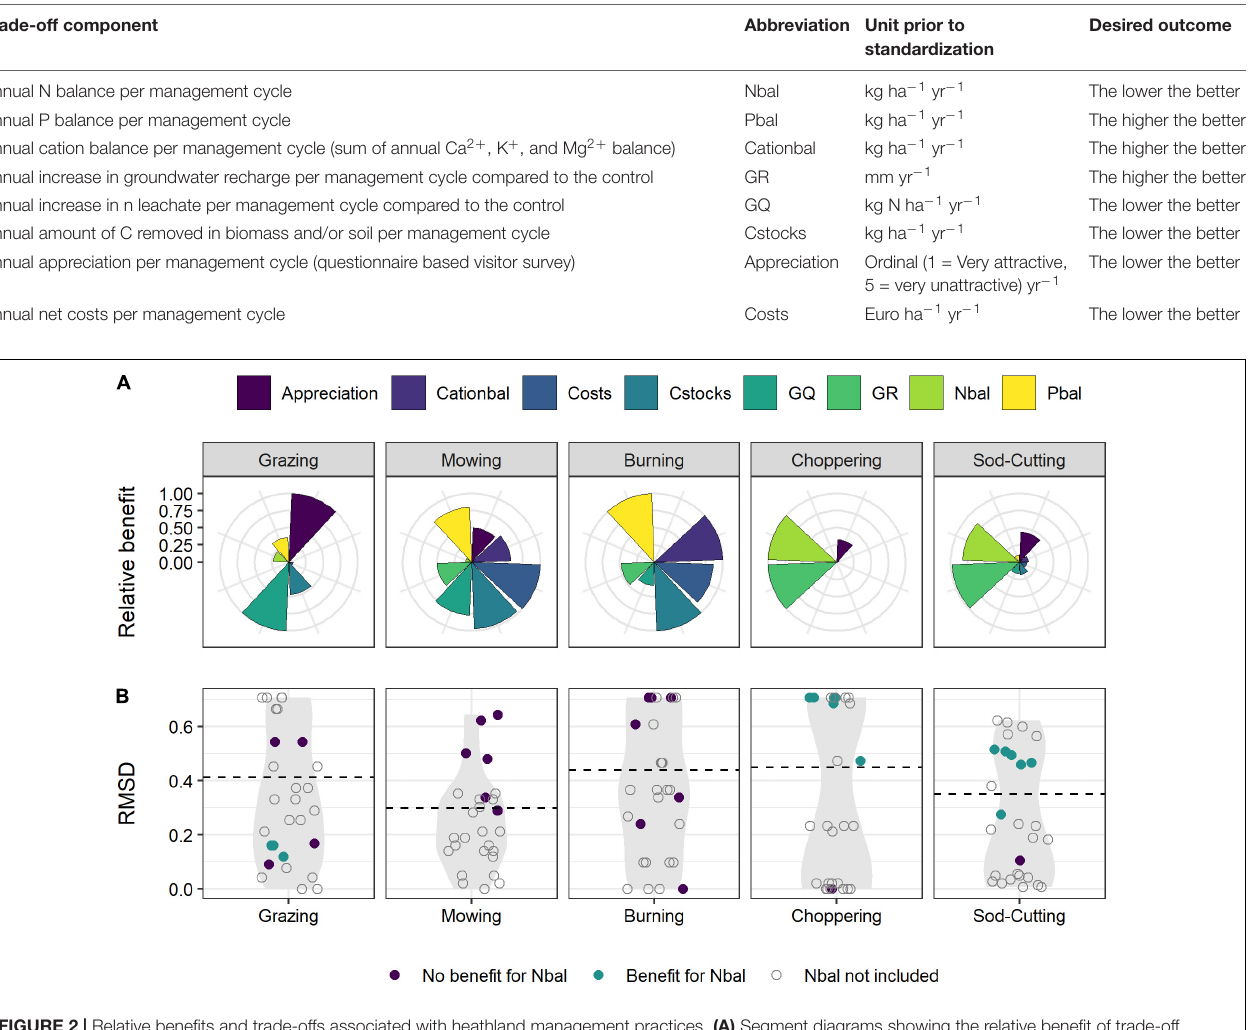
toward lower values (highest distribution density at RMSD ∼ 0.18, Figure 2B ) leading to an intermediate total trade-off value (RMSD total =